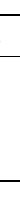
Table 3. Regression model accuracy values.